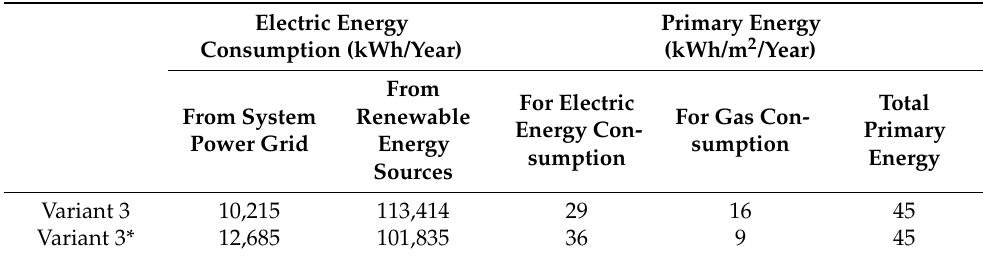
Table 5. Necessary share of electric energy from renewable energy sources installation to meet the limit value of total Primary Energy for the building.